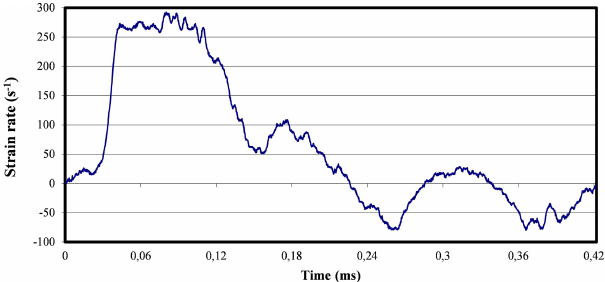
Figure 25. Incident and reflected stress waves at 3.5bar when using 1mm thick damping